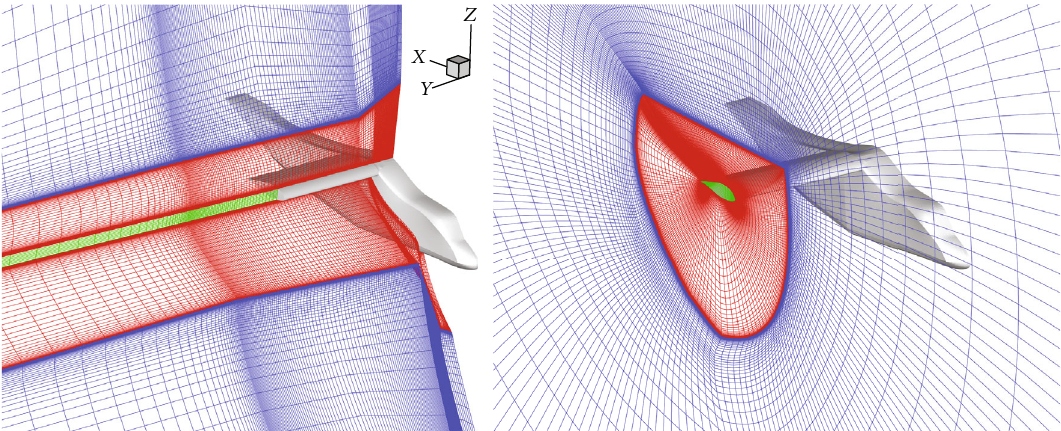
Figure 4: Cutaway view of mesh in helicopter mode.